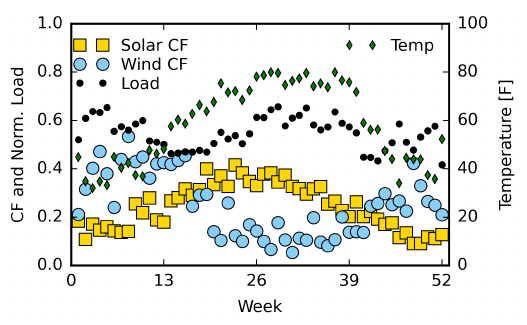
Figure 3. Average solar PV and wind capacity factor (CF), normalized load, and temperature in Fahrenheit with irradiance for each week across the year. The capacity factors for wind and solar peak in winter and summer, respectively, illustrating the complementary nature of the renewable